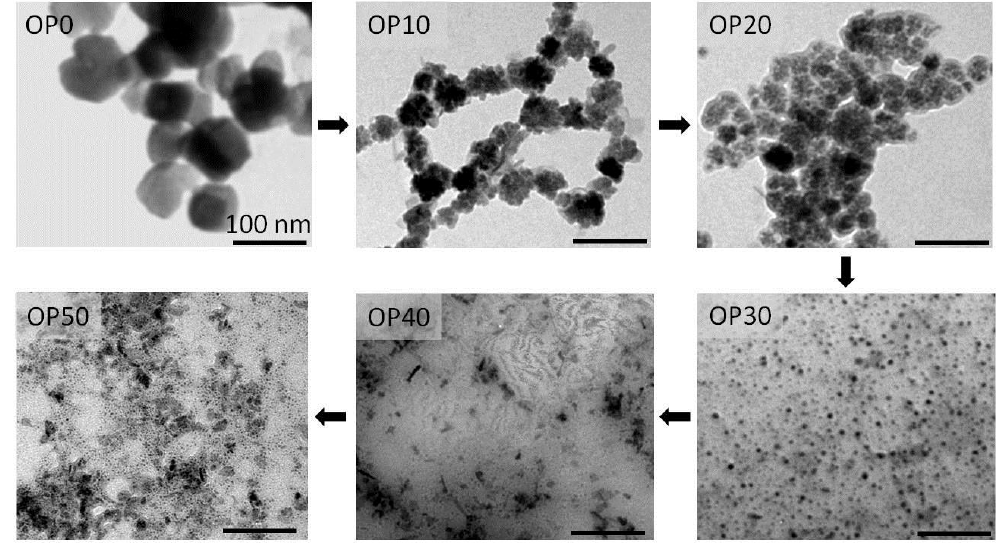
Figure 3. Evolution of the microstructures of MNCs obtained by oxidative precipitation as the proportion of PAANa increases.